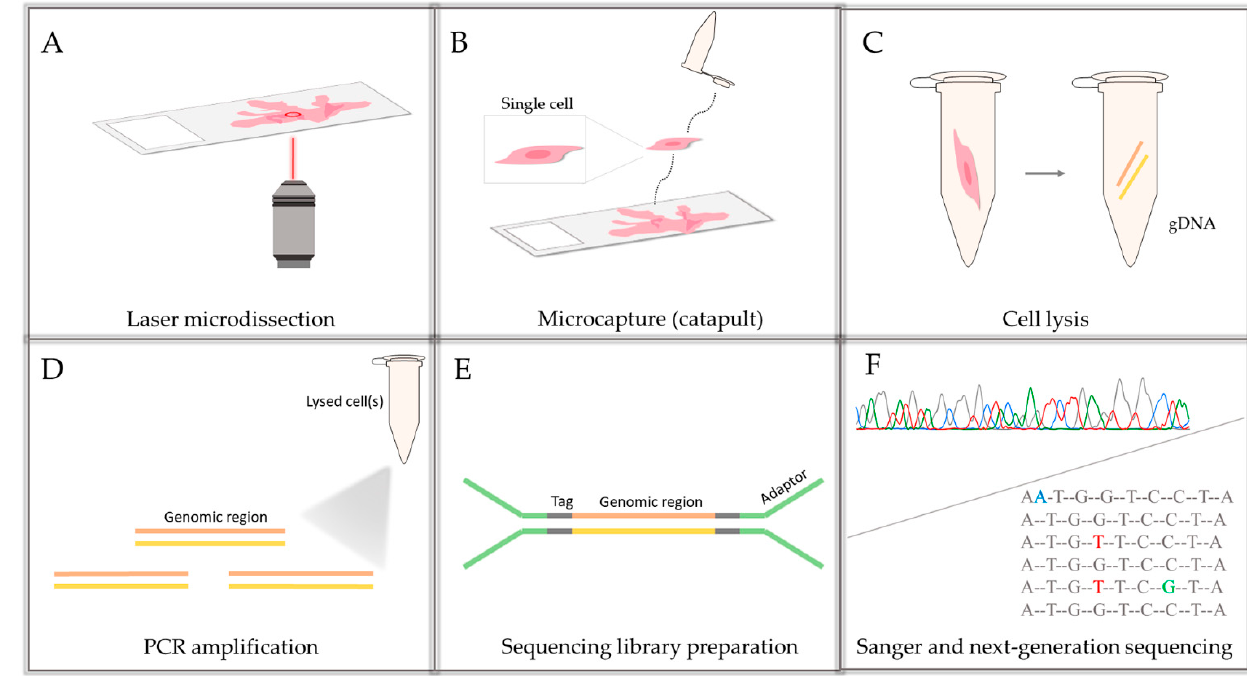
Figure 1. Schematic workflow for the single cells/small portion of cells: ( A ) selected cell(s) of interest are microdissected from the FFPE tissue based on the work of Brasko et al. [27]; ( B ) laser-dissected cells are catapulted into a PCR tube’s cap containing catapult buffer; ( C ) samples are lysed, the genomic DNA becomes accessible; ( D , E ) in a two-step PCR reaction, the genomic region of interest is amplified with universal tag sequences and Illumina specific adaptor sequences; ( F ) parallelly, Sanger and next-generation sequencing are performed on the amplicons.